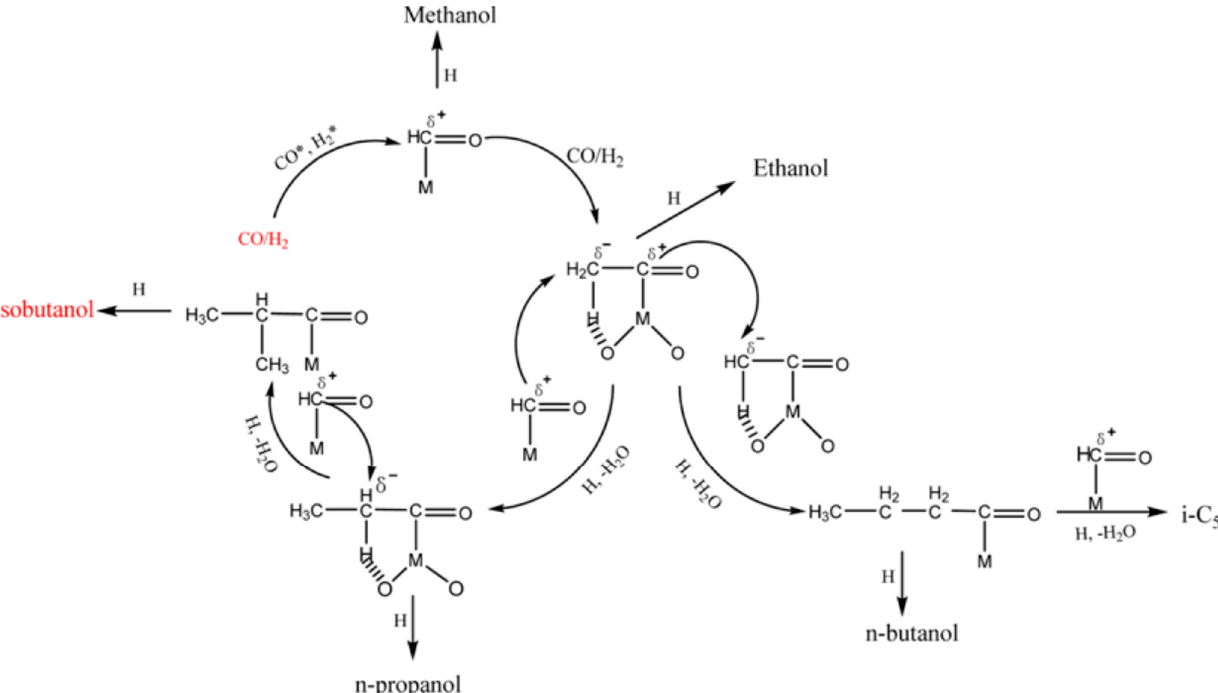
Figure 4. Reaction pathway for the formation of isobutanol from syngas. Reprinted from Wu et al. [82], Copyright (2014), with permission from Elsevier.